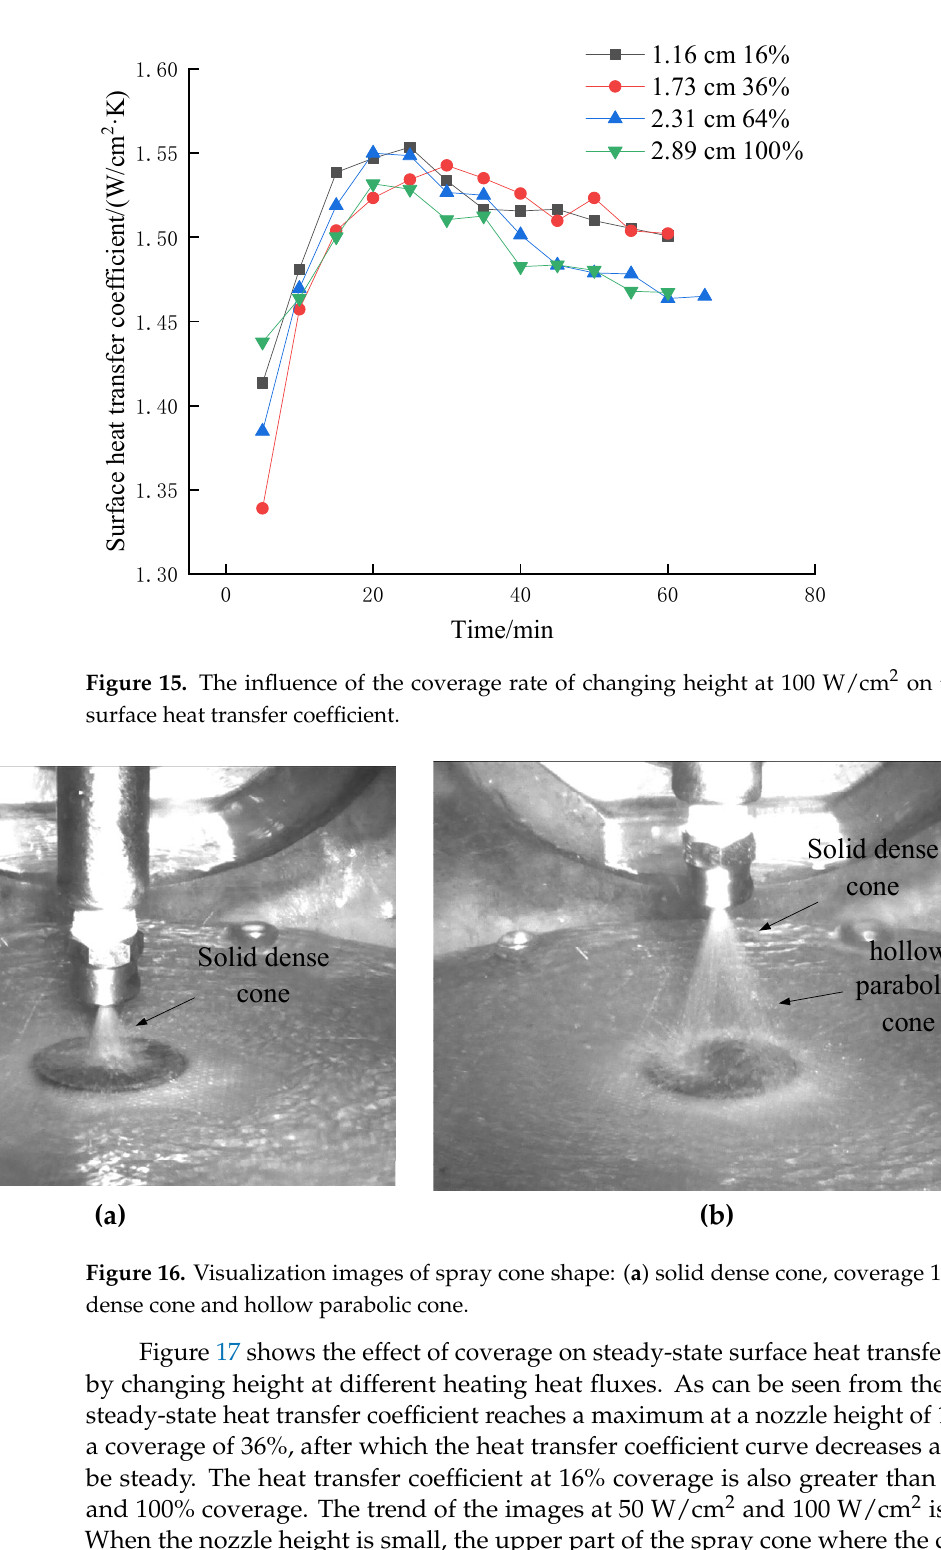
Figure 16. Visualization images of spray cone shape: ( a ) solid dense cone ， coverage16%; ( b ) solid dense cone and hollow parabolic cone.